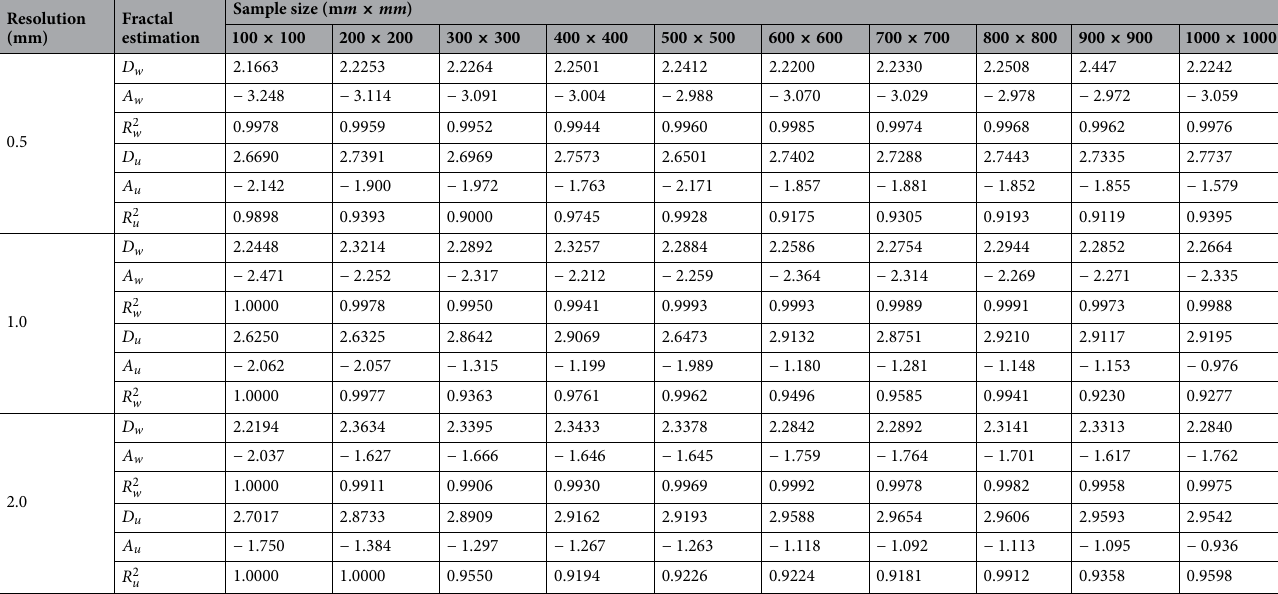
Table 2. Fractal dimensions of waviness and unevenness of rock joint sample S2 at varying sample sizes. D w and D u are fractal dimensions of waviness and unevenness, respectively. A w and A u are the coefficients during linear correlation for estimating D w and D u , respectively. R during linear correlations for estimating D w and D u ,